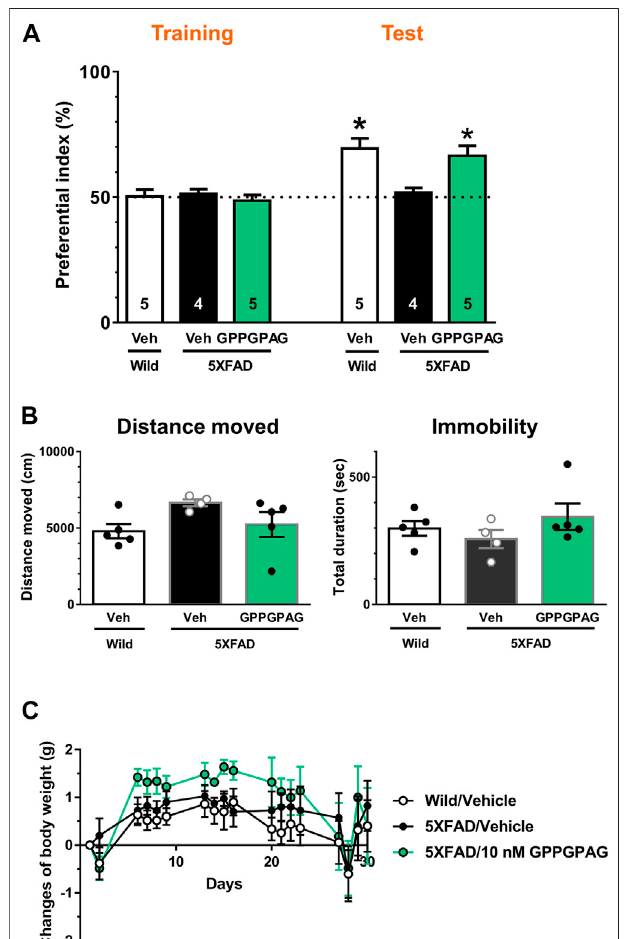
FIGURE 4 | Effect of i.c.v. infusion of GPPGPAG on object recognition memory de fi cits in 5XFAD mice (A) GPPGPAG or vehicle solution (arti fi cial cerebrospinal fl uid; ACSF) was continuously administered to the lateral ventricle for 28 days in mice (male and female, 24 – 27 weeks old). The dose of GPPGPAG was set as 10 nM in CSF. An object recognition test was carried out with a 3 h interval time. The preferential indices of the training and test sessions are shown. * p < 0.05 vs. vehicle-treated 5XFAD mice, repeated measures two-way ANOVA with post hoc Bonferroni ’ s test. mean ± standard error.Wild-type(male, n (cid:2) 5),vehicle-treated5XFADmice(male, n (cid:2) 2;female, n (cid:2) 2), GPPGPAG-infused 5XFAD mice (male, n (cid:2) 2; female, n (cid:2) 3). (B) Locomotion was evaluated by open fi eld test. Distance moved and duration with immobility were shown. mean ± standard error (C) Changed values of body weight of mice during whole experimental period are shown. Repeated measures two-way ANOVA revealed no signi fi cant difference among four groups. mean ± standard